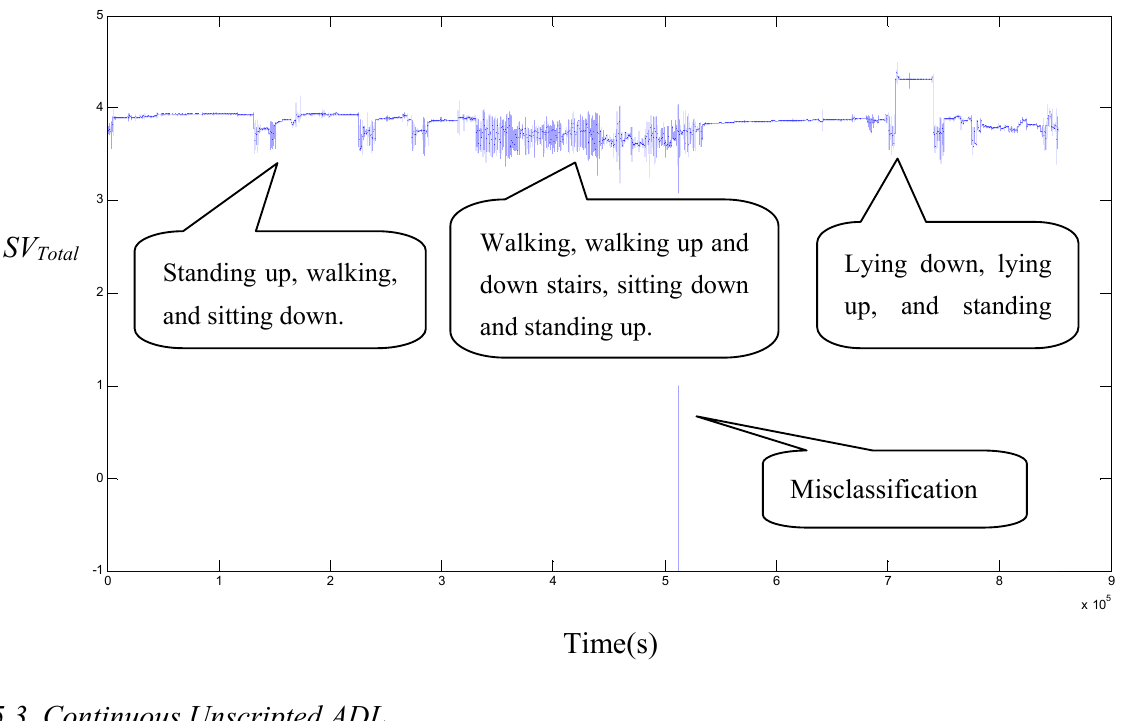
Figure 3. The SV signal of continuous actions of the EF_3 Total